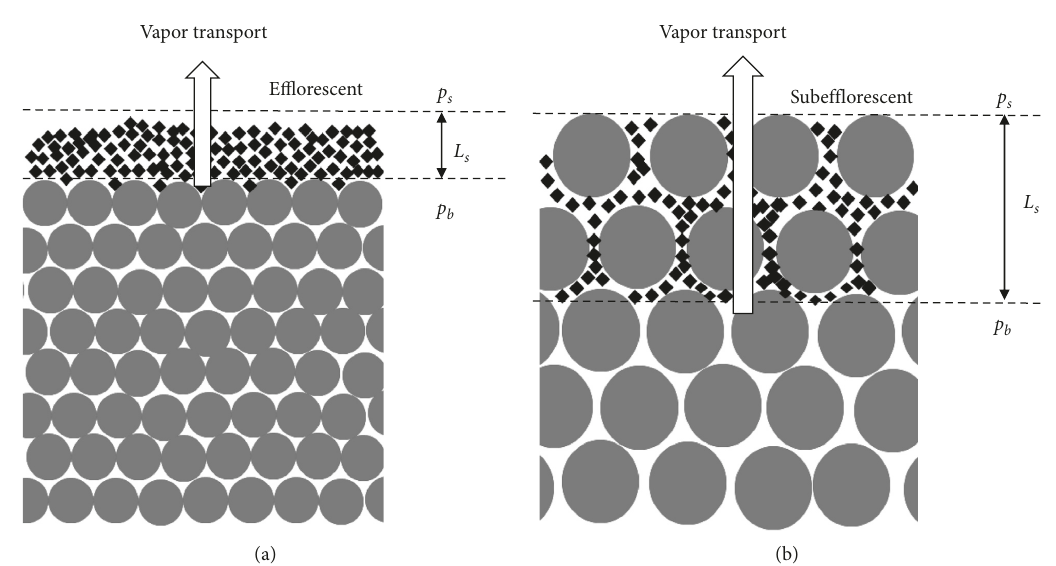
Figure 7: Scheme of vapor transport through efflorescently precipitated salt in fine sand (a) and (b) subefflorescently precipitated salt in coarse